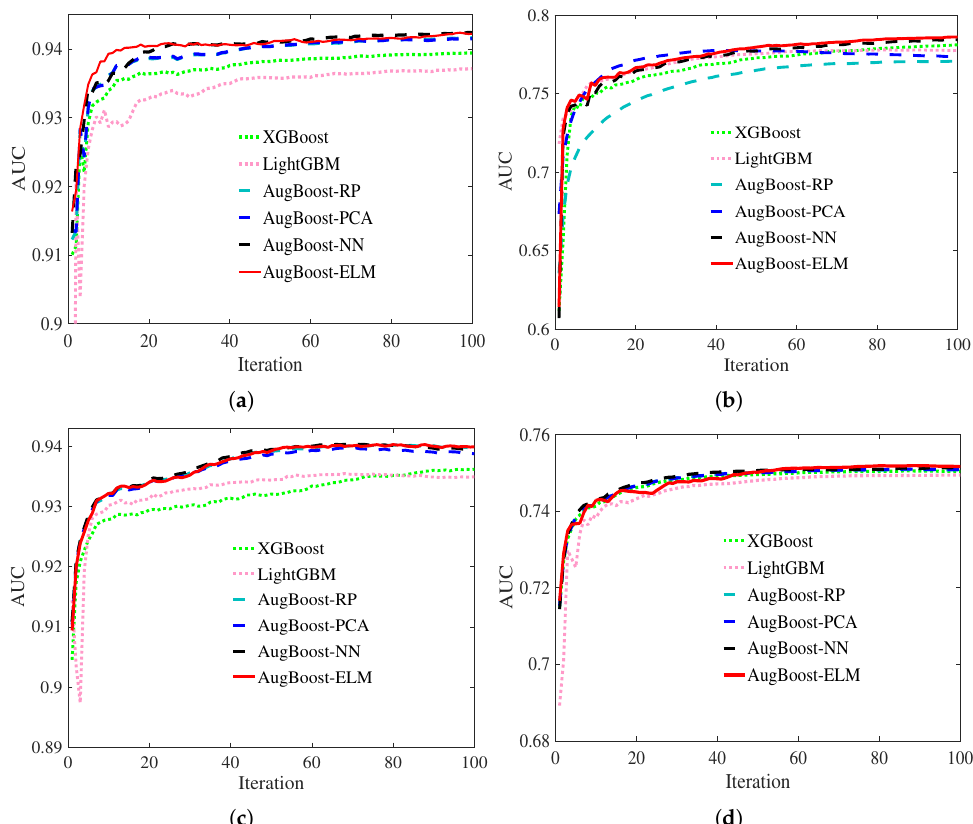
Figure 3. Comparison of testing AUC for the credit datasets. ( a ) Australian, ( b ) German, ( c ) Japanese, ( d )